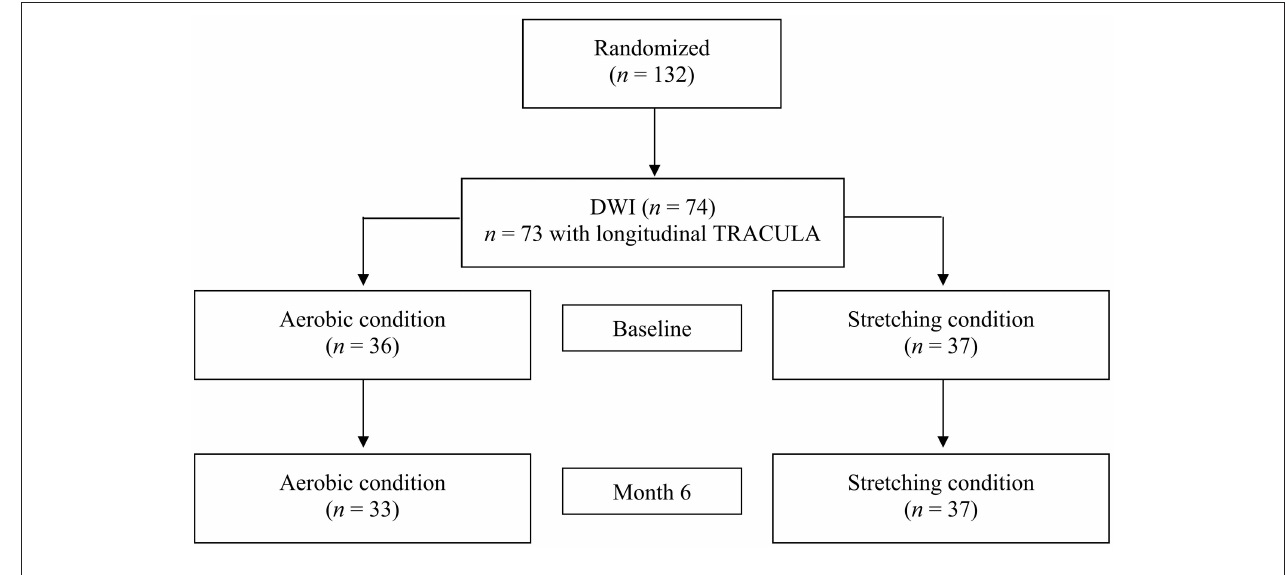
FIGURE 1 | Flowchart.